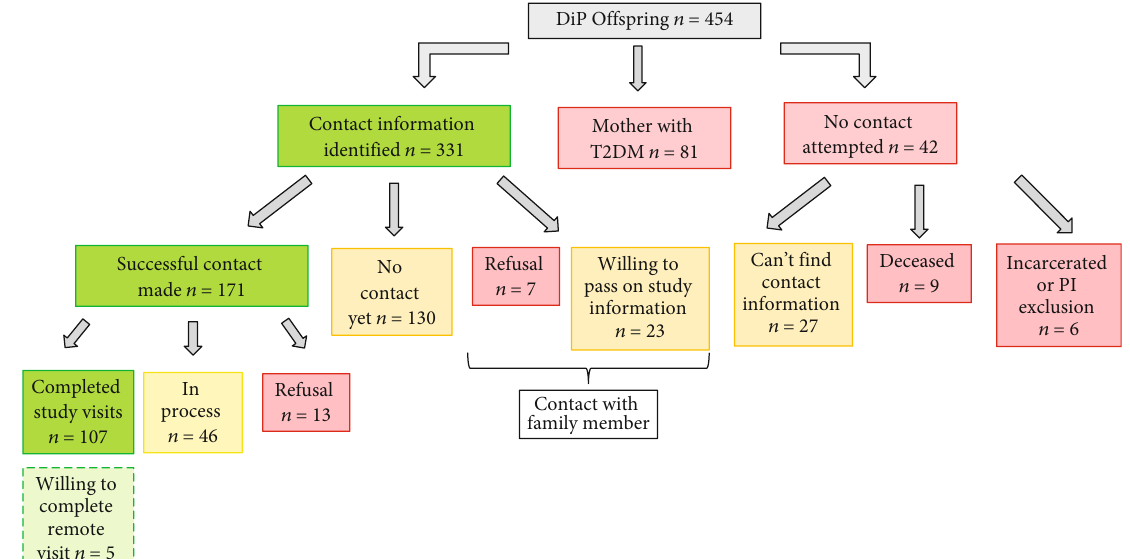
Figure 1: Eligible participant identi fi cation, contact attempts, and enrollment in the TEAM